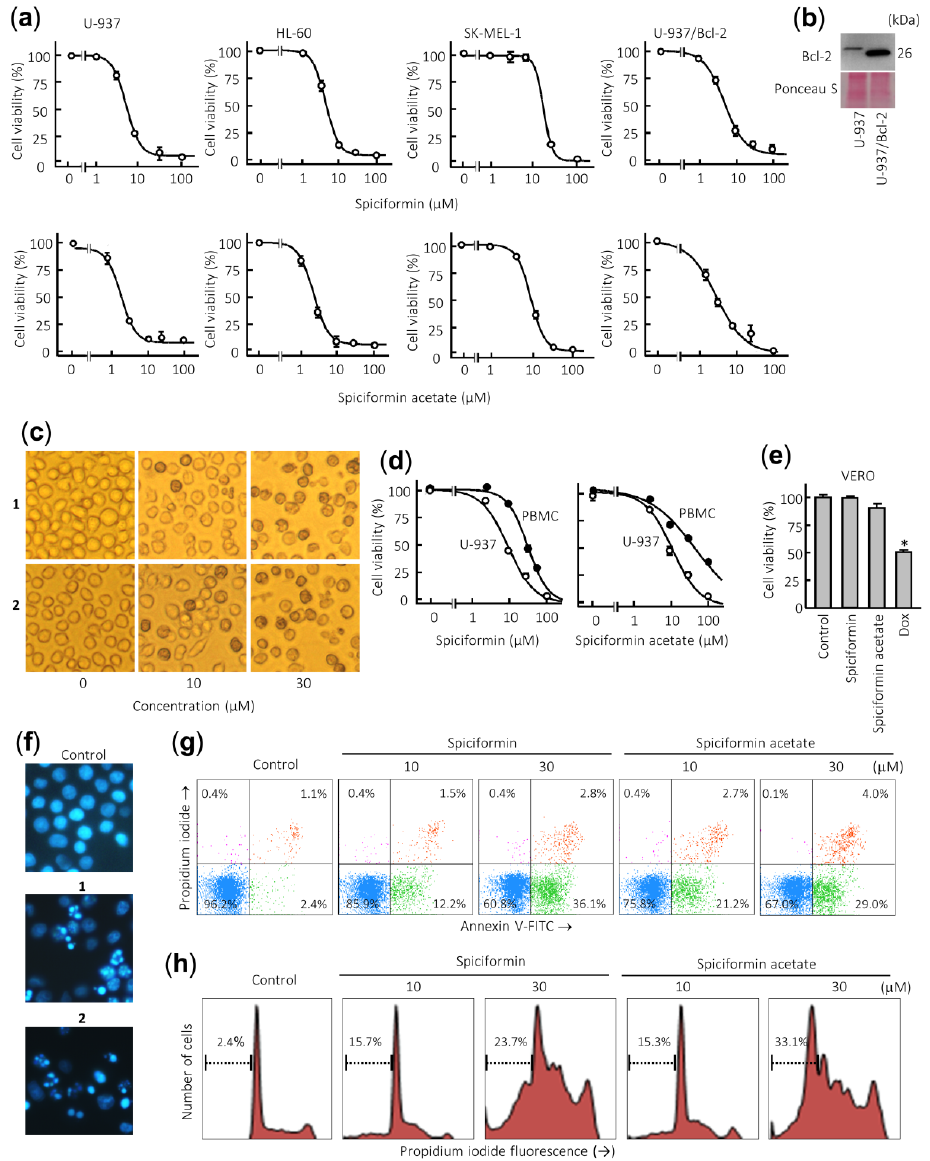
Figure 2. Effects of sesquiterpene lactones 1 and 2 on human tumor cells. ( a ) Dose–response study on human cancer cell lines. Cells were cultured in the presence of increasing concentrations of spiciformin or spiciformin acetate for 72 h, and then the cell viability was determined by the 3-(4,5-dimethyl-2-thiazolyl)-2,5-diphenyl-2 H -tetrazolium bromide (MTT) assay. ( b ) Immunoblot analysis of Bcl-2 protein in U-937 and U-937 / Bcl-2. The membrane was stained with Ponceau S to control equal protein loading. ( c ) U-937 cells were incubated with the indicated concentrations of the specified compounds for 24 h and visualized with an inverted phase-contrast microscope. Original magnification 40 × . ( d ) Differential effects of sesquiterpene lactones on viability of normal mononuclear cells from peripheral blood (PBMCs) versus U-937 cells. Quiescent PBMC from healthy human origin and human leukemia cells were treated with increasing concentrations of 1 and 2 for 24 h. ( e ) Effect of 100 µ